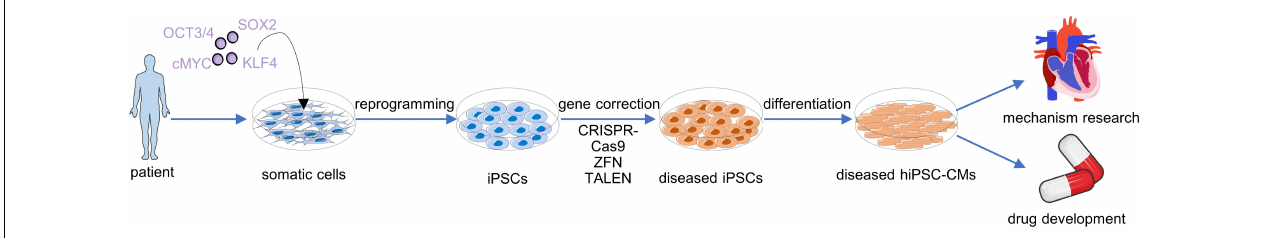
FIGURE 2 | The whole process of constructing hiPSC-derived cardiomyocyte (hiPSC-CM) disease model from patients’ somatic cells and the application of these disease models.